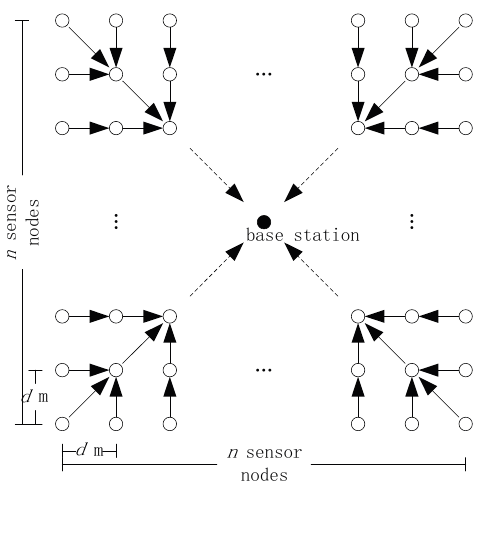
Figure 6. Square-grid